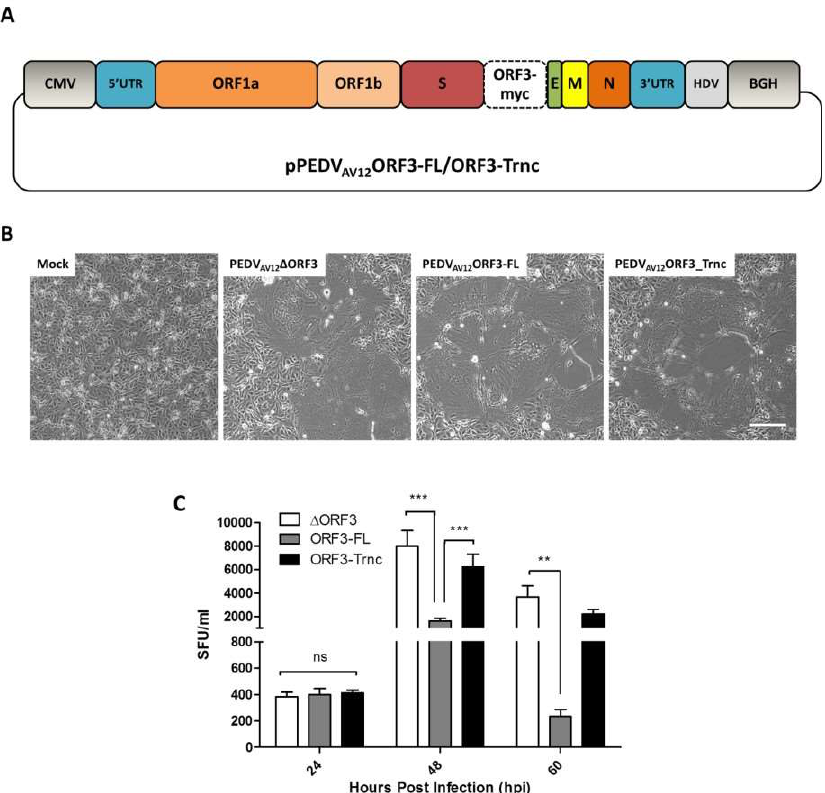
Figure 1. Generation of porcine epidemic diarrhea virus AVCT12 (PEDV AV12 ) infectious clones and growth kinetics of PEDV AV12 carrying myc-tagged ORF3. ( A ) schematic representation of PEDV AV12 infectious clone carrying myc-tagged ORF3 including the full length (ORF3-FL) or truncated ORF3 genes (ORF3-Trnc); ( B ) the PEDV AV12 infectious clones (pPEDV AV12 _ORF3-FL and-Trnc) were transfected into VeroE6-APN cells. At 48 hpi, syncytium formation was detected in the transfected VeroE6-APN cells. pPEDV AV12 with deletion of ORF3 gene ( ∆ ORF3) was used as a control. Scale bar is 100 µ m; ( C ) the reverse genetics-derived PEDV AV12 - ∆ ORF3, ORF3-FL and-Trnc were inoculated onto VeroE6-APN cells at the multiplicity of infection (MOI) of 0.2. The viruses were harvested at 24, 48 and 60 hpi and subjected to syncytia forming unit assay (SFU) for virus titration. Statistical analysis was performed by using the two-way ANOVA method; error bars represent the means ± standard error of means of virus titers. ns; no statistical significance, ** p < 0.01 and *** p < 0.001.